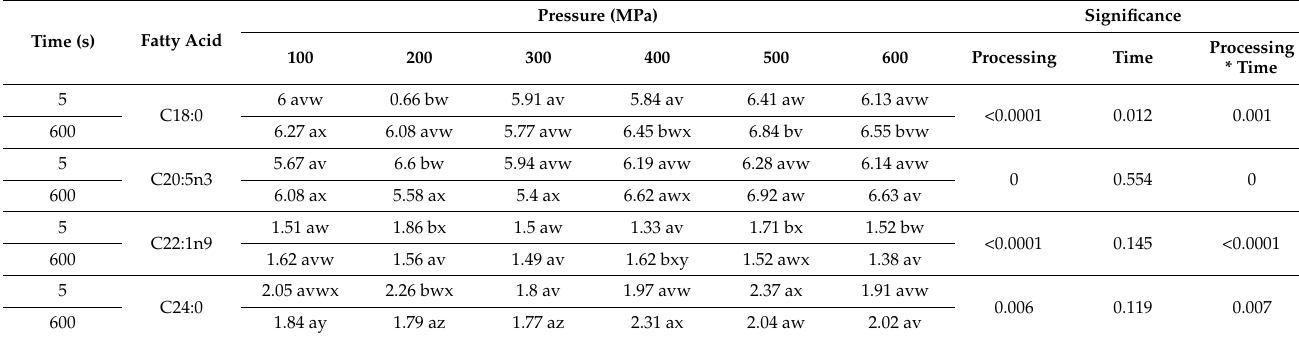
Table 2. Fatty acids composition of Diamond Shell ( Spisula aequilatera ) clam. a,b means with different letters in a row show the significant effect of time in each processing pressure; v,w,x,y,z means with different letters in column show the significant effect of time under the same processing pressure. * Compounds identified with VID coefficients higher than